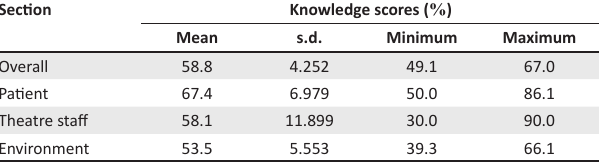
TABLE 2: Anaesthetists’ knowledge of airborne infections. Section